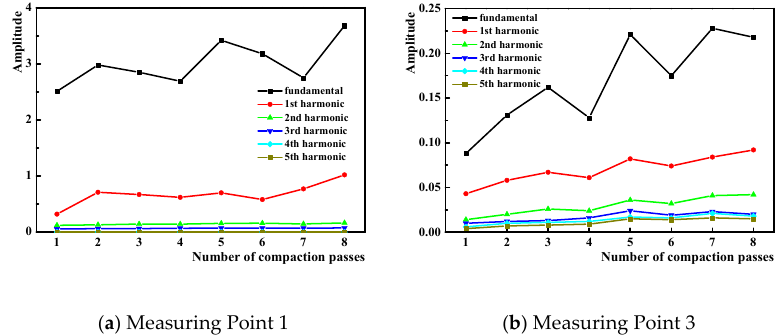
Figure 10. Relationship between amplitude of harmonic and rolling compaction times.